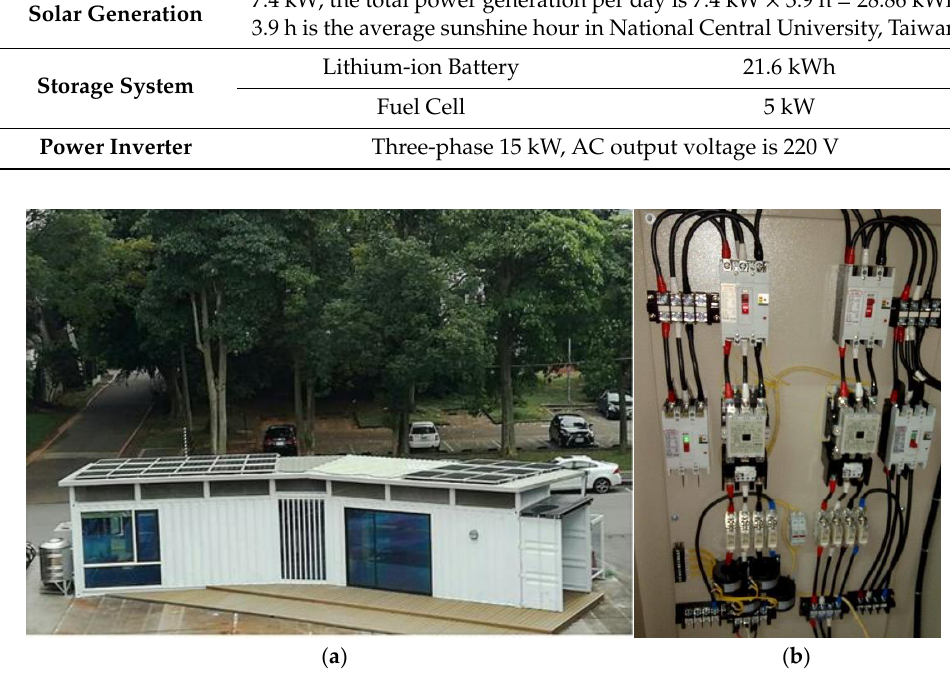
Figure 10. ( a ) Microgrid system and ( b ) protective relay for the system.